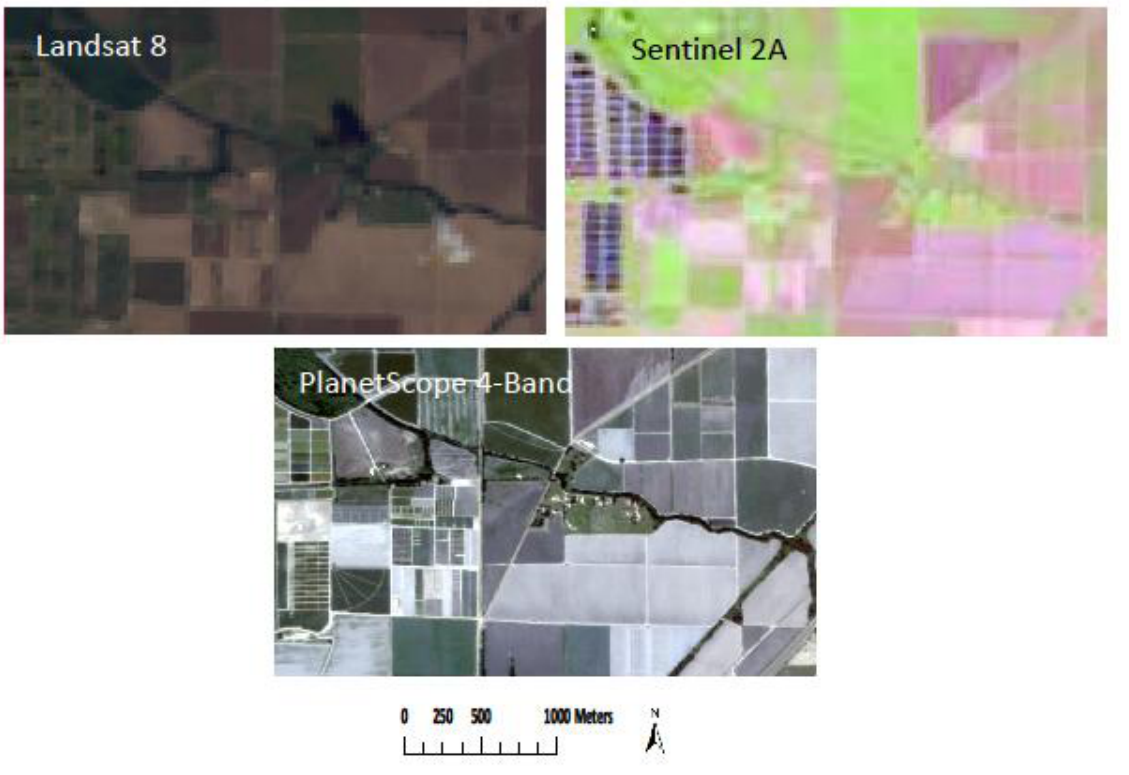
Figure 5. Cotton yield estimation based on CUC quantified through thresholding of LoG of UAV RGB images (the square shapes represent data points, and the solid line is the trend of the data points with the fitted regression equation as shown on the top).